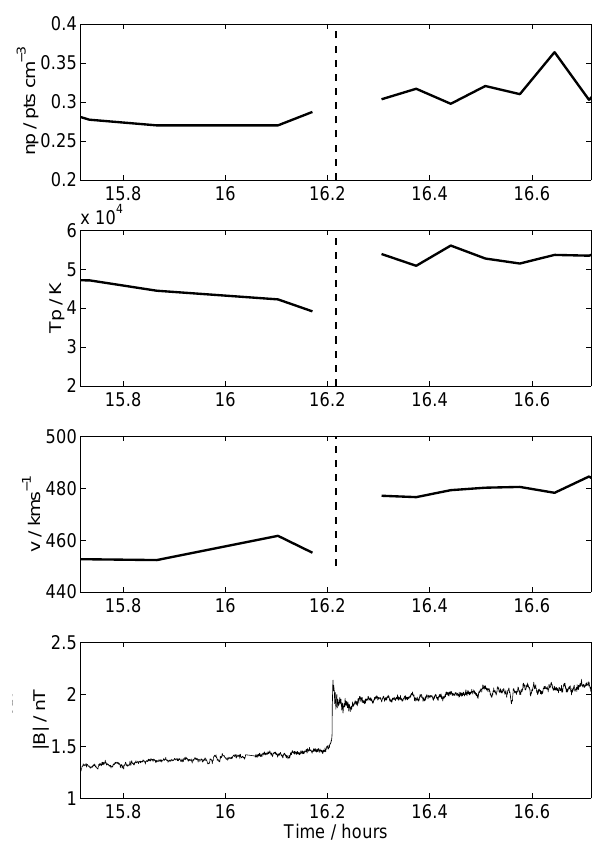
Fig. 1. Example low r B shock occurring on day 128, 1998 show- ing proton density (top panel), proton temperature (2nd panel), pro- ton bulk velocity (3rd panel) and magnetic field magnitude (bottom panel).